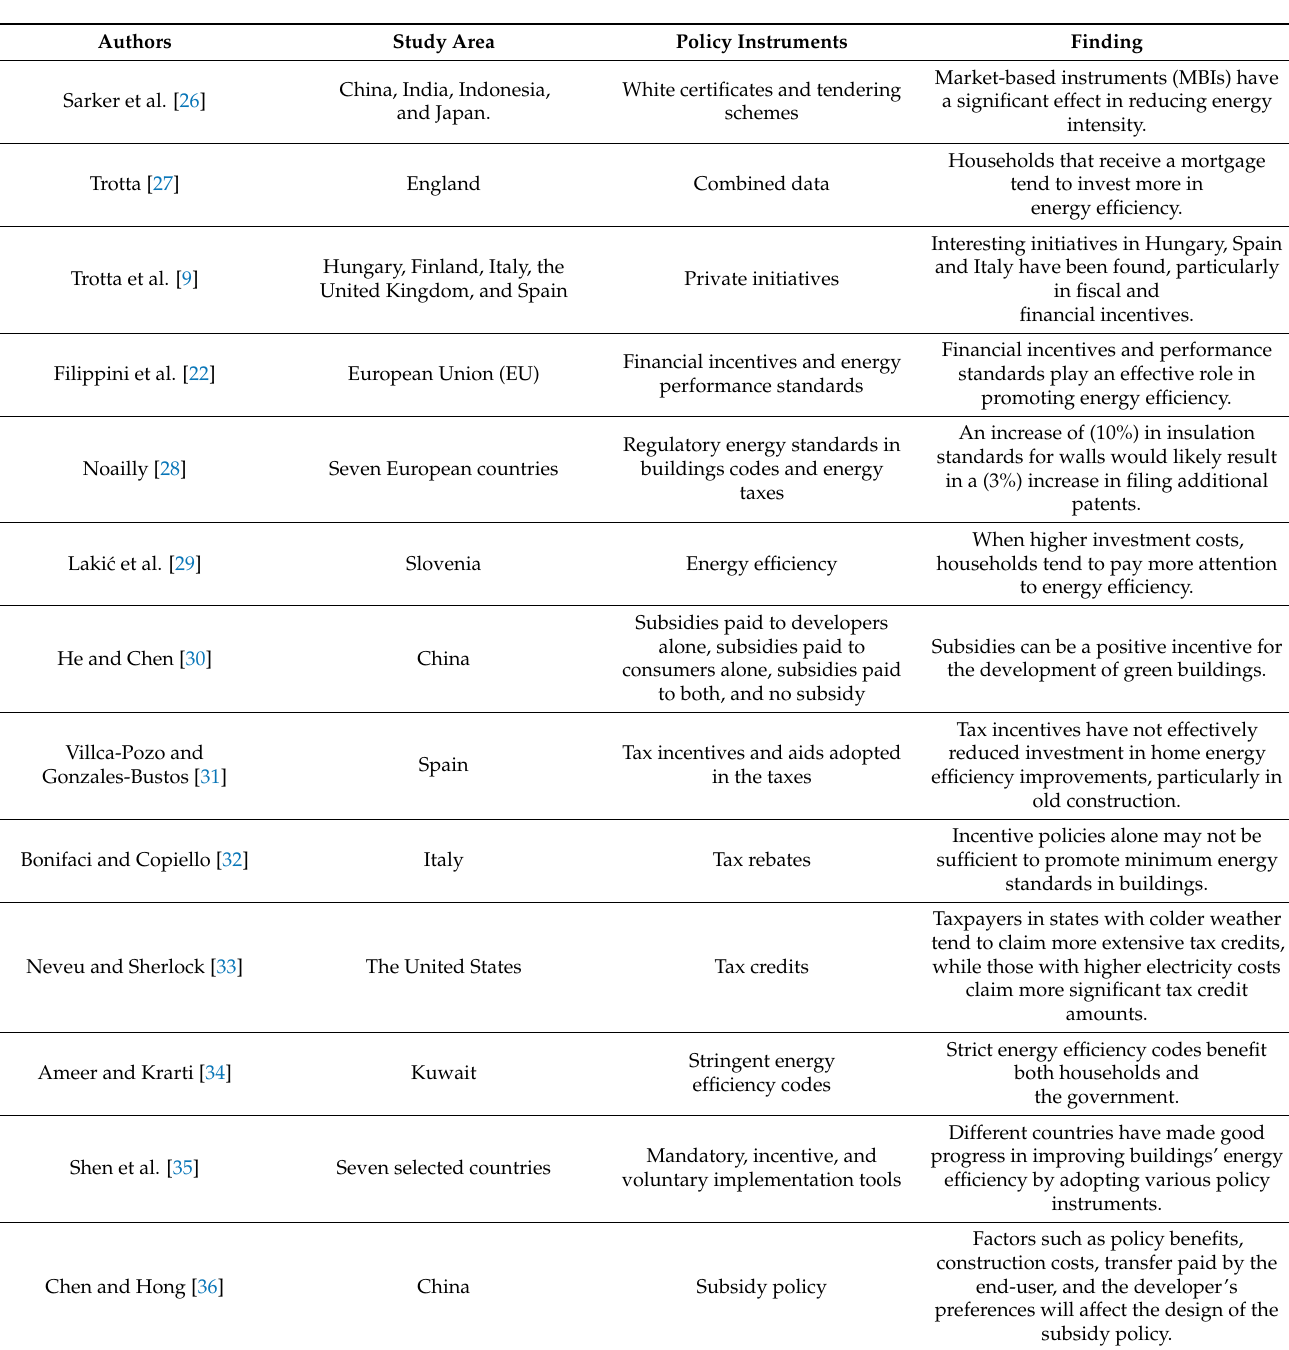
Table 1. Summary of literature